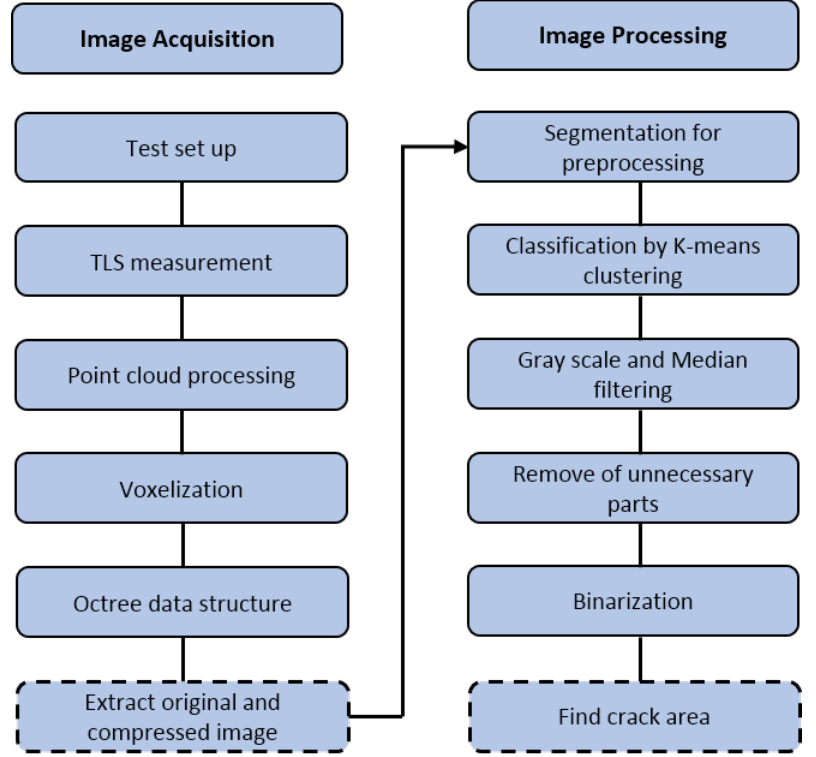
Figure 1. The workflow of crack detection by terrestrial laser scanning (TLS) measurement.